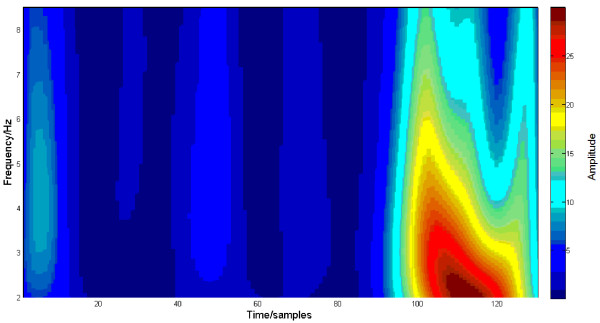
MWT on trace in Figure 2.